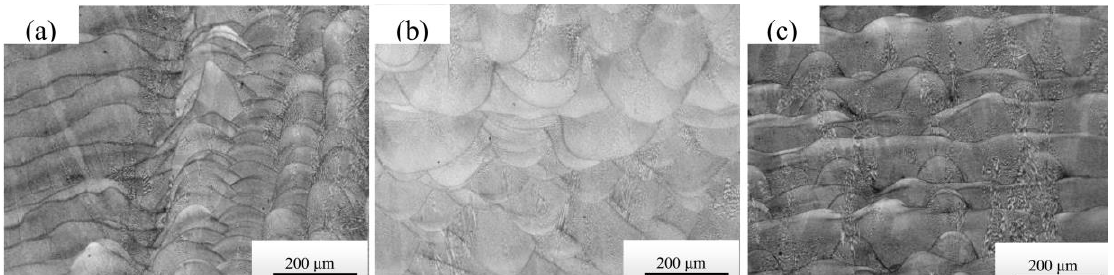
Figure 15. Microstructures of three different scanning strategies: ( a ) Normal partition strategy; ( b ) spiral divisional strategy; ( c ) “ s ” style orthogonal scanning strategy.